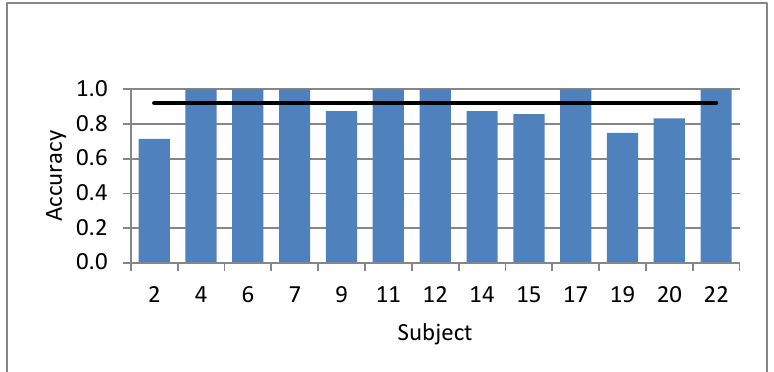
Figure 1. Perception accuracy in L2 English for obstruent devoicing at T1.